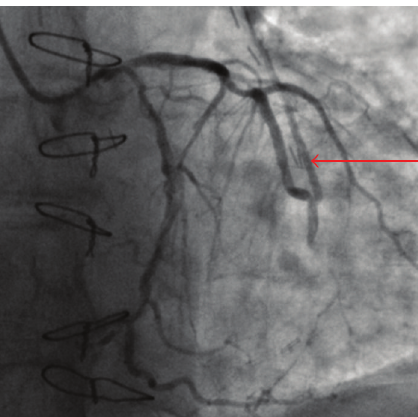
Figure 1: (a) Angiography of the left coronary artery. Optimal anastomosis of the LIMA to the LAD. Retrograde blood flow in the left mammary artery graft to the LAD—initial phase (arrow).